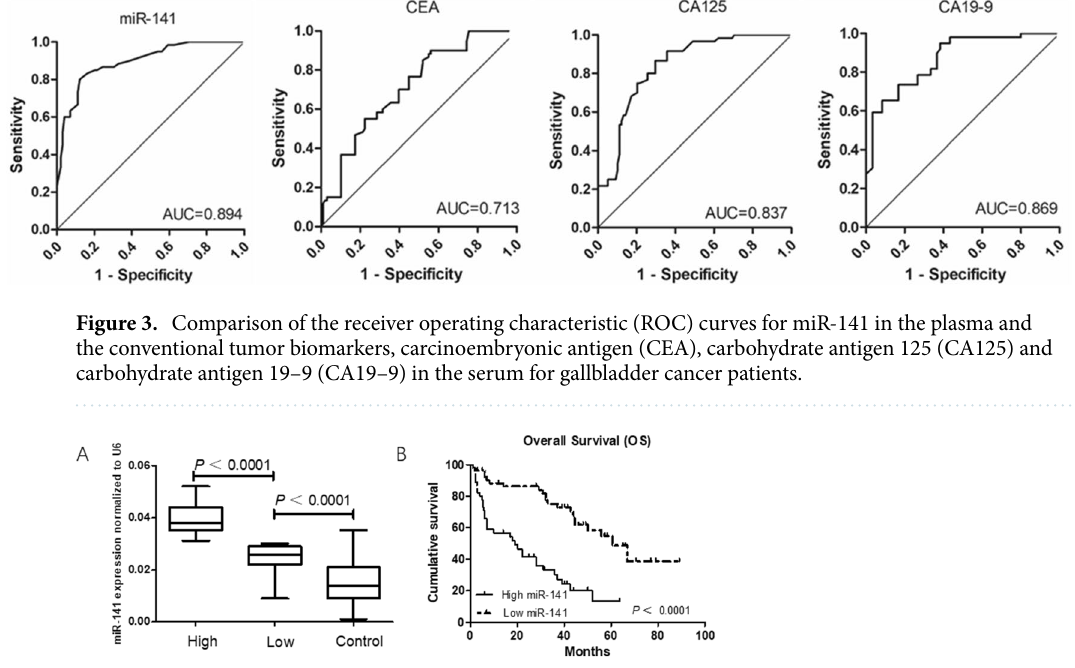
Figure 4. Survival analysis of 98 gallbladder cancer (GBC) patients stratified by high versus low miR-141 expression in plasma. ( A ) The levels of plasma miR-141 in the high-expression and low-expression and controls groups. ( B ) Kaplan–Meier analysis showing that the GBC patients with high miR-141 expression in the plasma displayed poorer OS ( P < 0.0001; log-rank